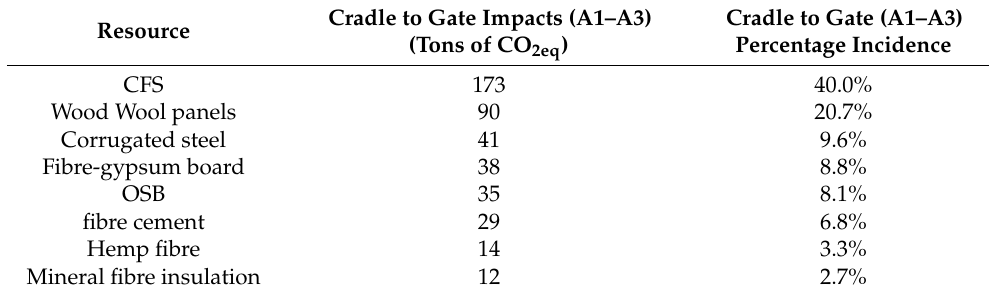
Table 15. Overall and percentage impact of each British Defense School construction material.